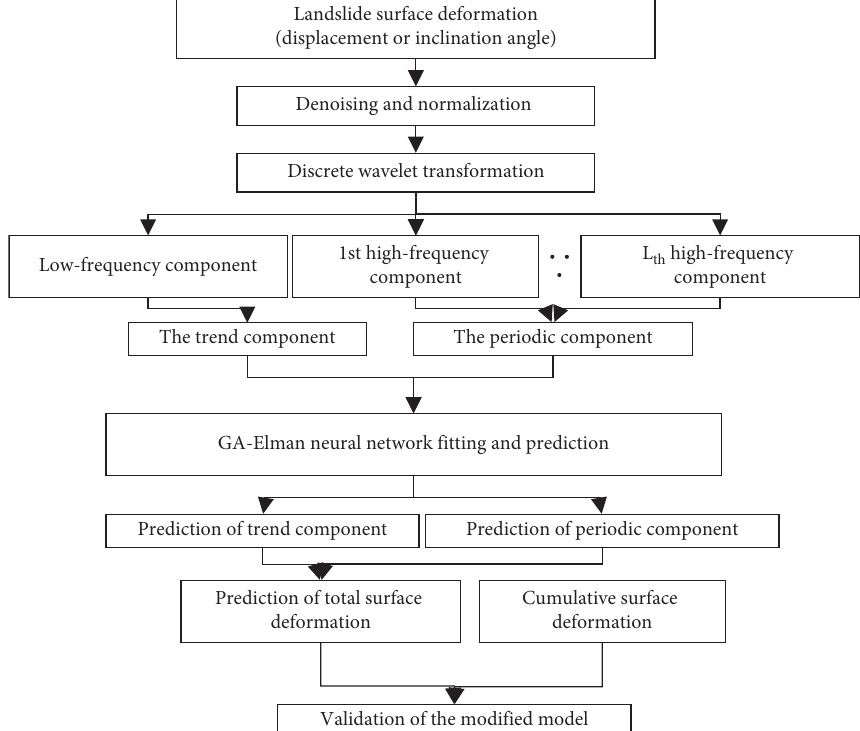
Figure 1: Flowchart of the WA-GA-Elman model (L denotes the number of the layer).